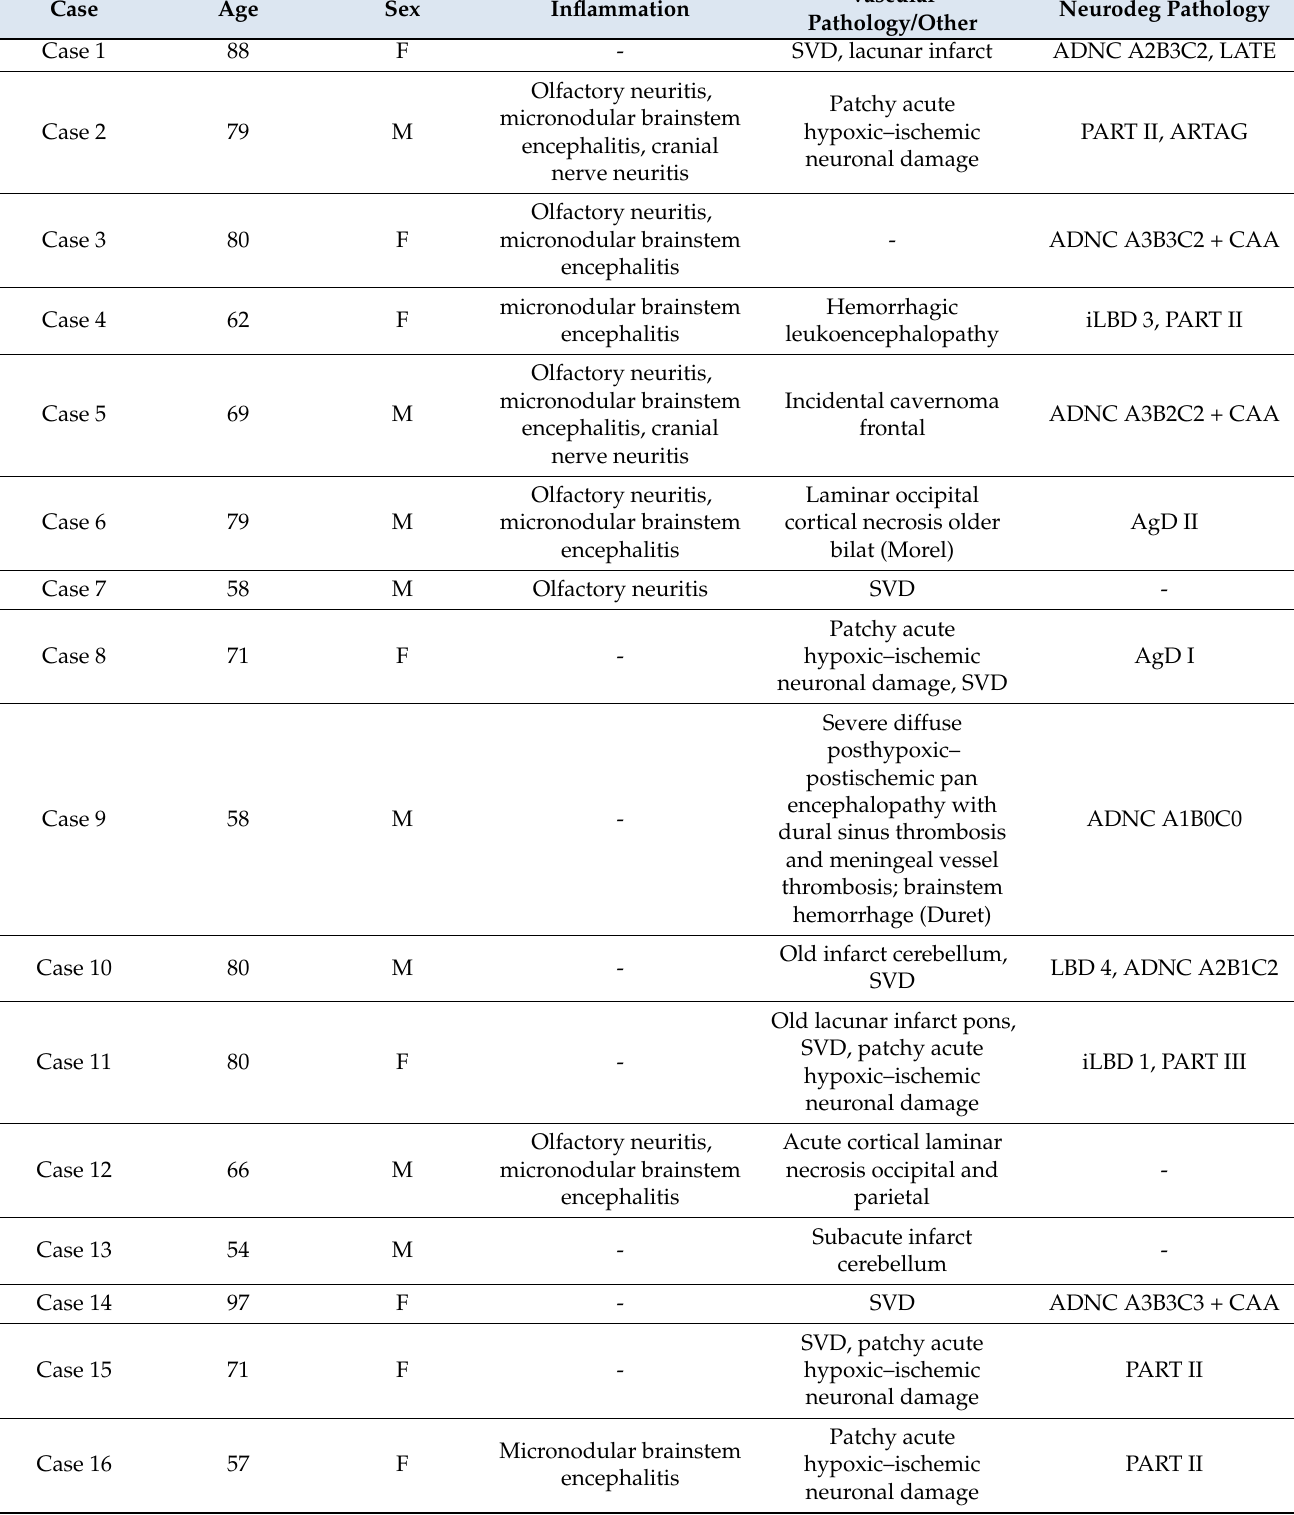
Table 5. Individual neuropathological